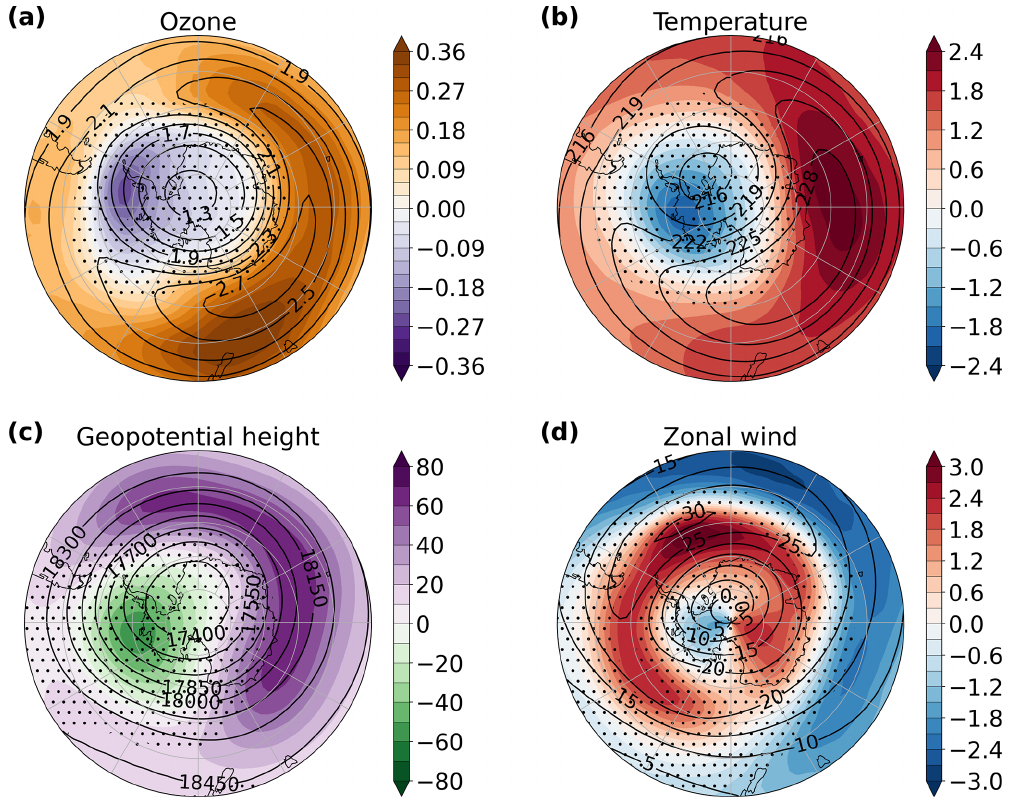
Figure 5. Polar stereographic maps of the difference between INTERACT O 3 and FIXED O 3 in the October mean ozone ( a ; ppmv) and the November mean temperature ( b ; K), geopotential height ( c ; m), and zonal wind ( d ; ms − 1 ) at 70hPa (color shading). The stippling masks regions that are not significant at the 95% confidence interval. The overlaying contours mark the 1958–2013 INTERACT O 3 climatology of each respective variable and